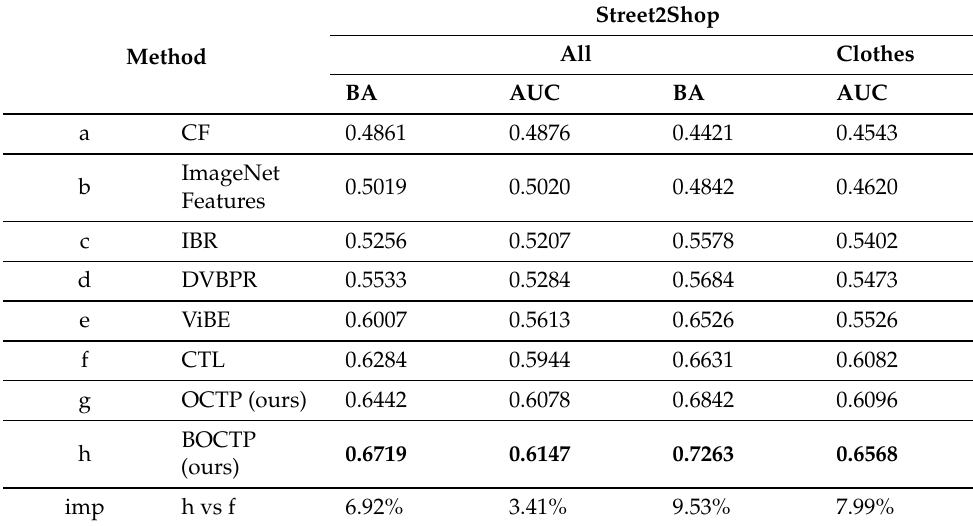
Table 3. Binary Accuracy (BA) and AUC on Street2Shop dataset for non-label-given outfit completion. Under the dataset name, ‘all’ denotes the whole dataset which includes clothes, shoes and accessories, while ‘clothes’ only contains clothing items.